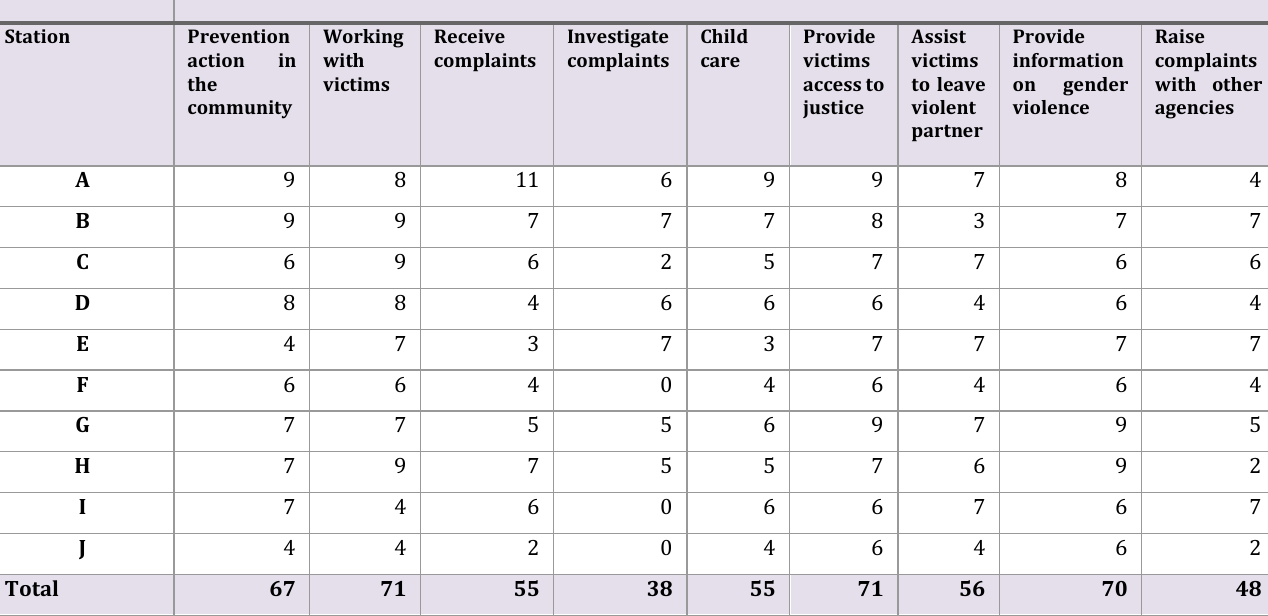
Table 5: Routine Roles of Employees at W omen’s Police Stations Which one of the following best describes your role at the Women’s Police